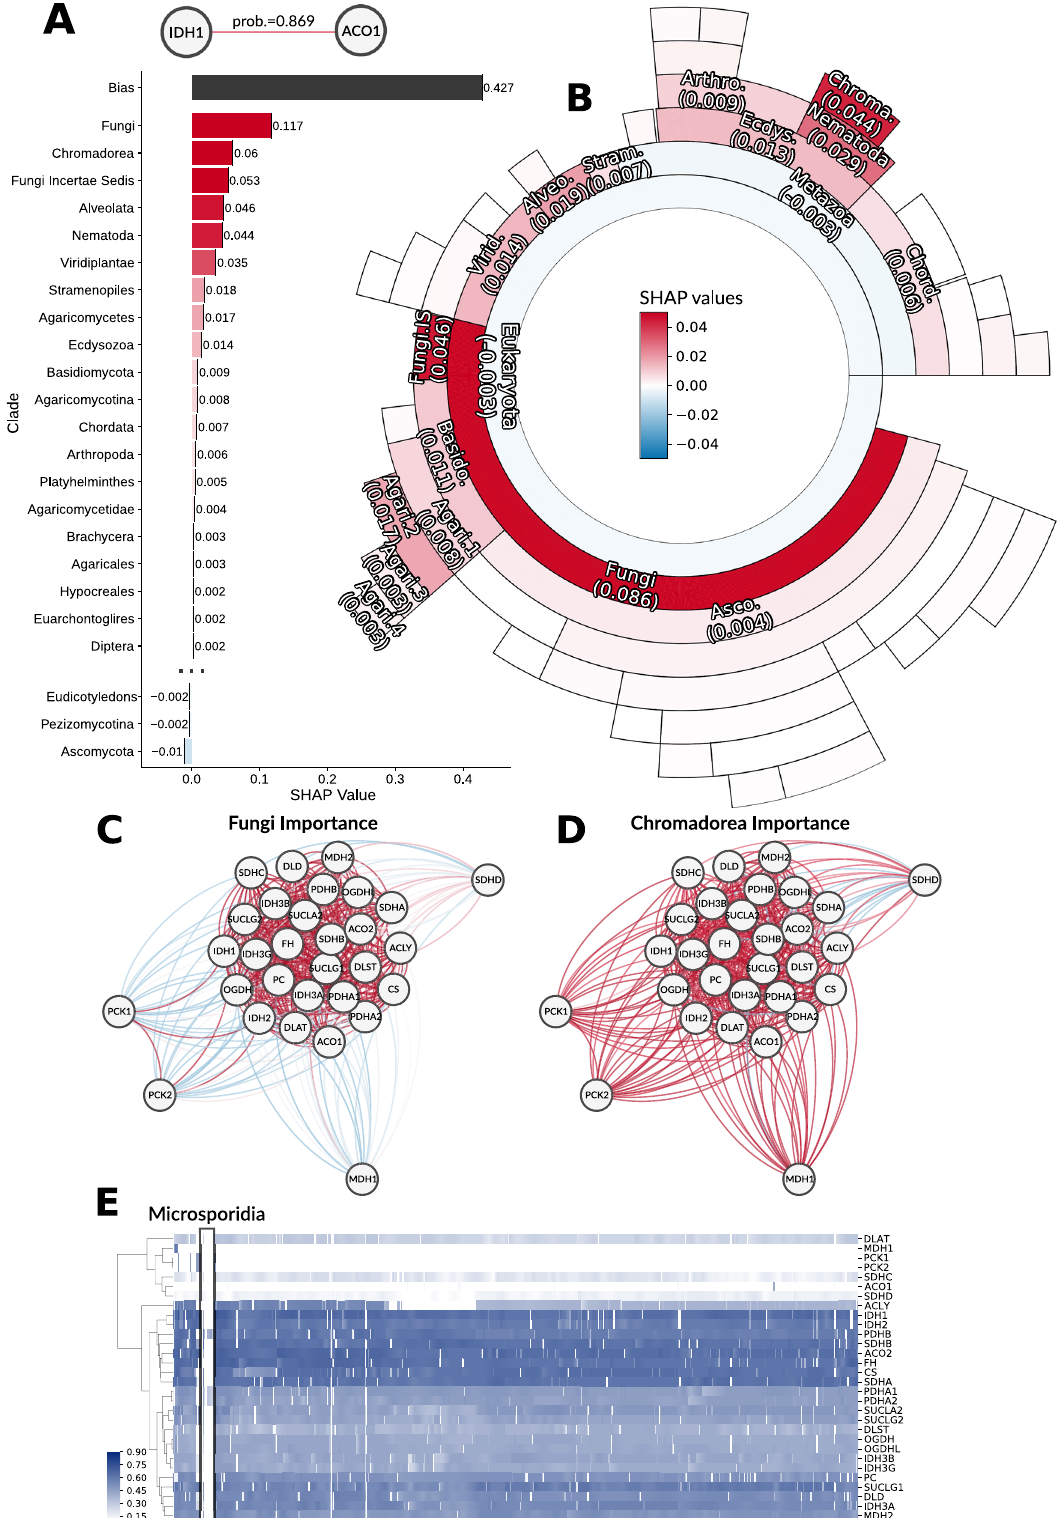
Six parasites containing clades were further compared to non- parasitic (free-living or mutualistic) organisms in the same clades and a reference parent clade (Fig. 7B, C, a full list of organisms considered parasitic can be found in Supplementary Table 5, see “ Methods ”